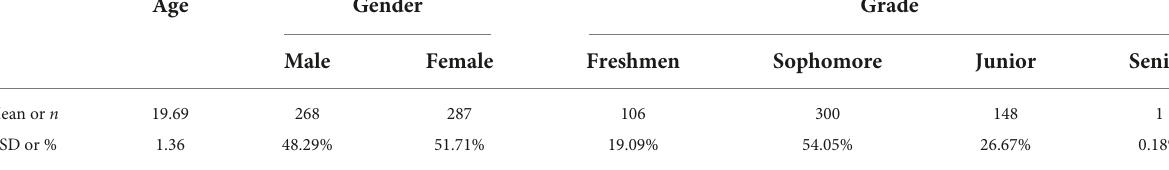
TABLE 1 Participants’ characteristics ( n =